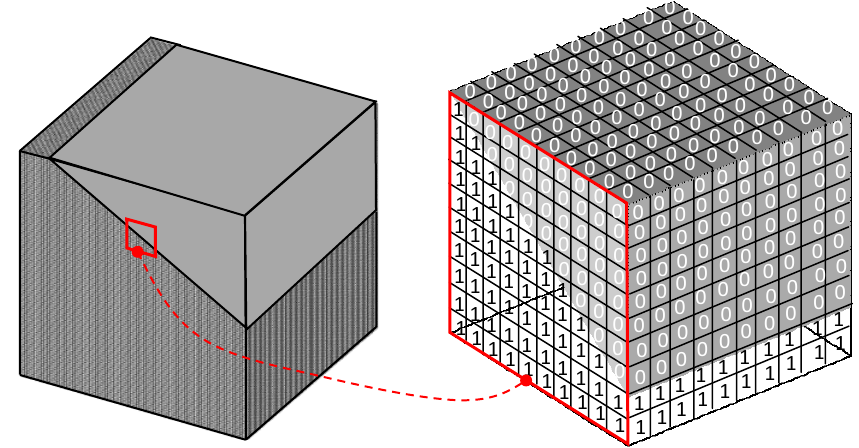
Figure 3. Blocked-off-region technique.